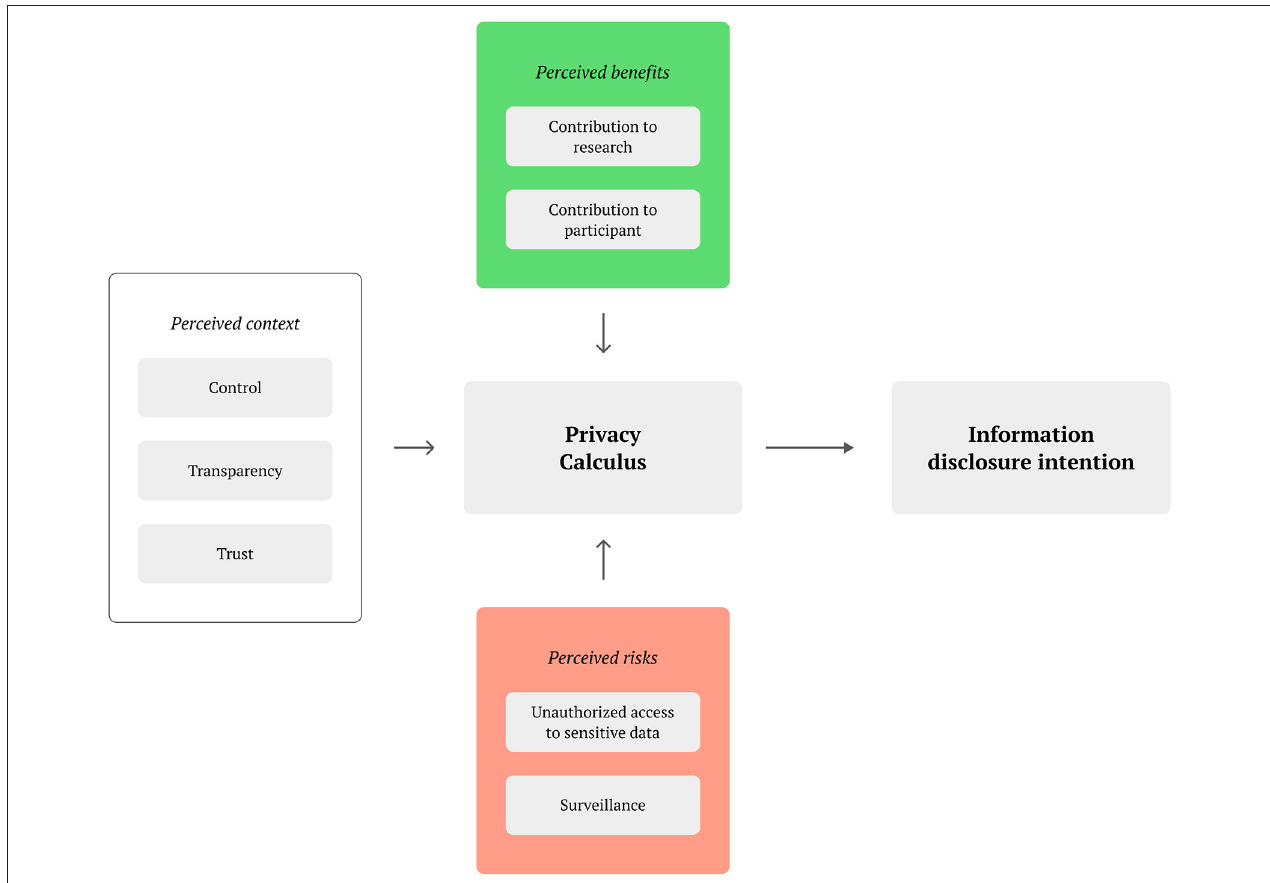
FIGURE 1 | Privacy calculus in citizen science health